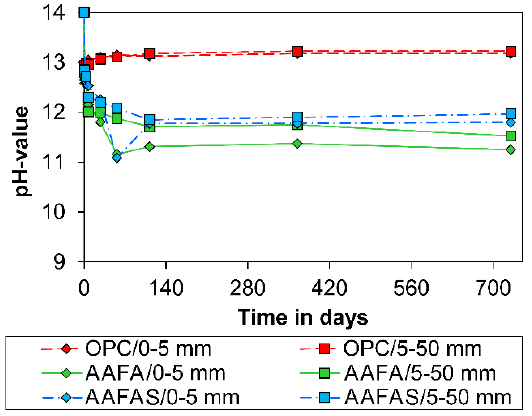
Figure 5. Development of pH value at different depths in concrete under 20 °C/65% rH/0.00 Vol.-% CO 2.